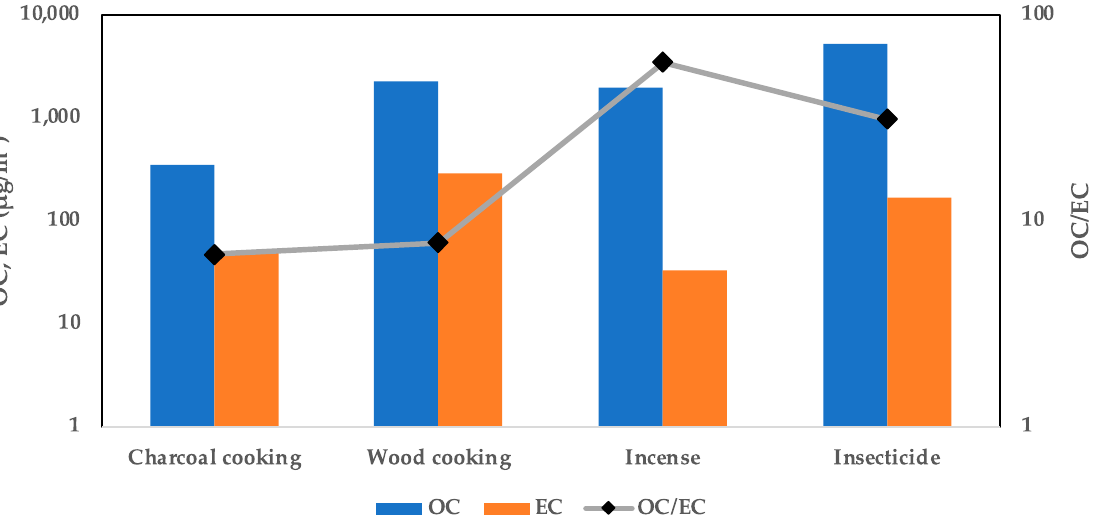
Figure 5. Average elemental carbon and organic carbon concentrations in different particulate matter samples collected by in situ samplings (charcoal cooking, wood cooking, IST: insecticide, and ICS: incense).